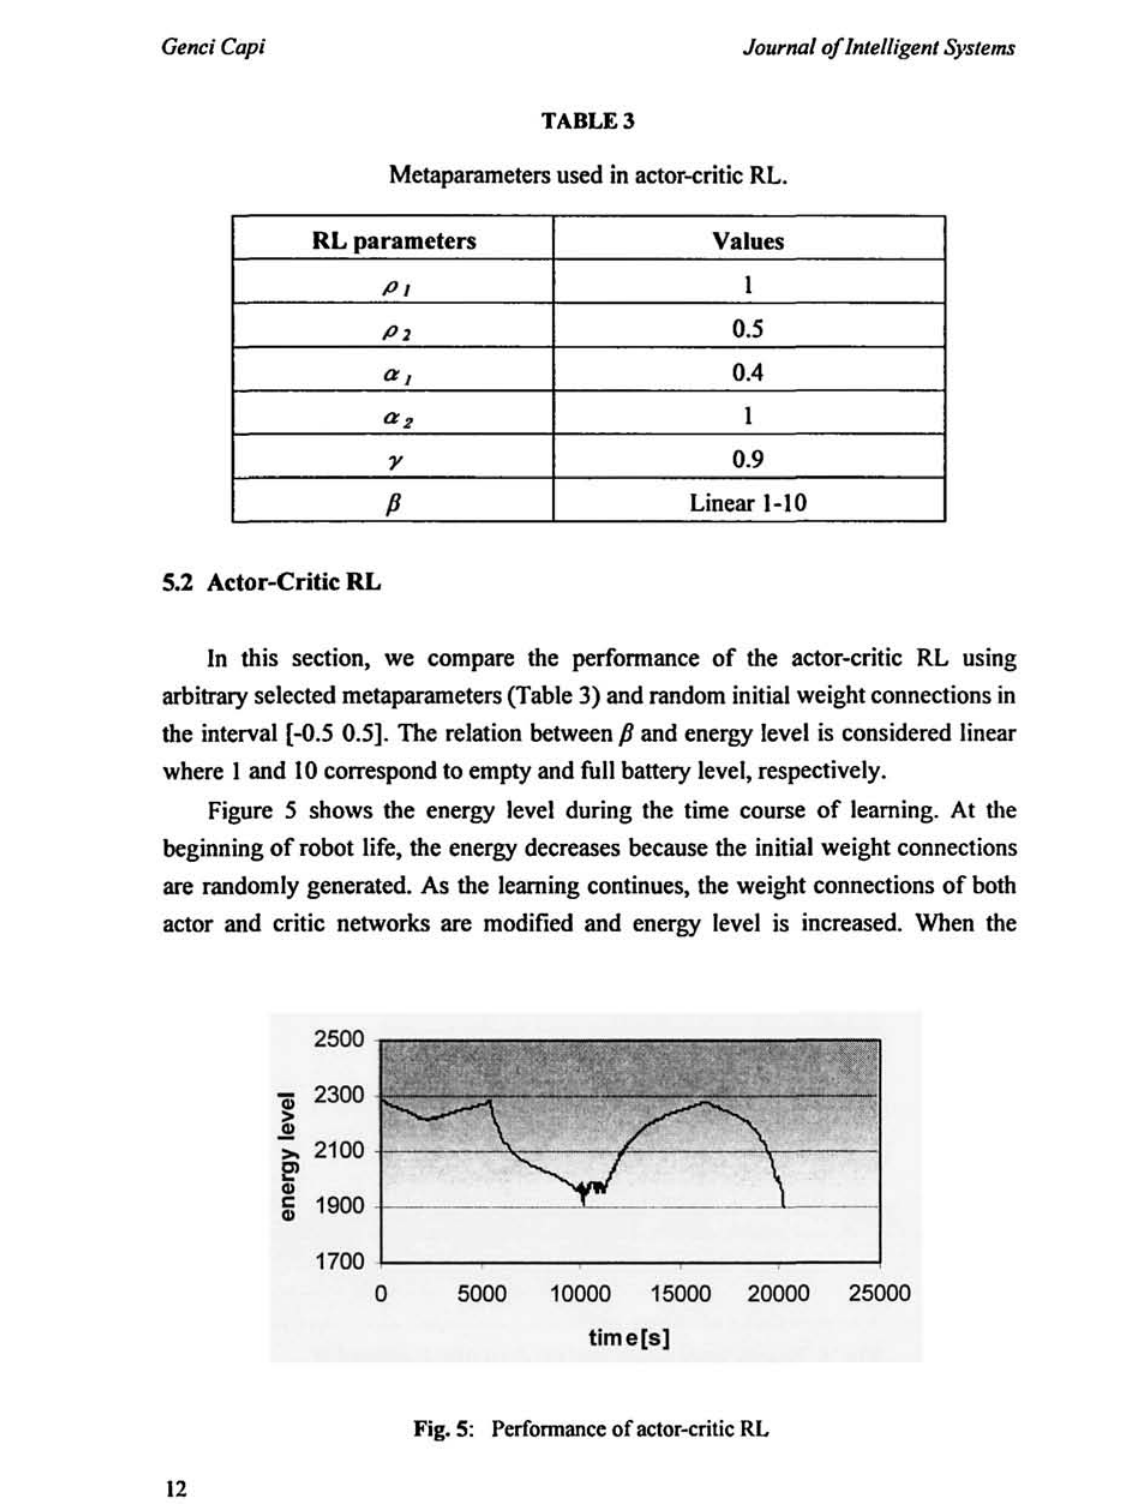
Fig. 5: Performance of actor-critic